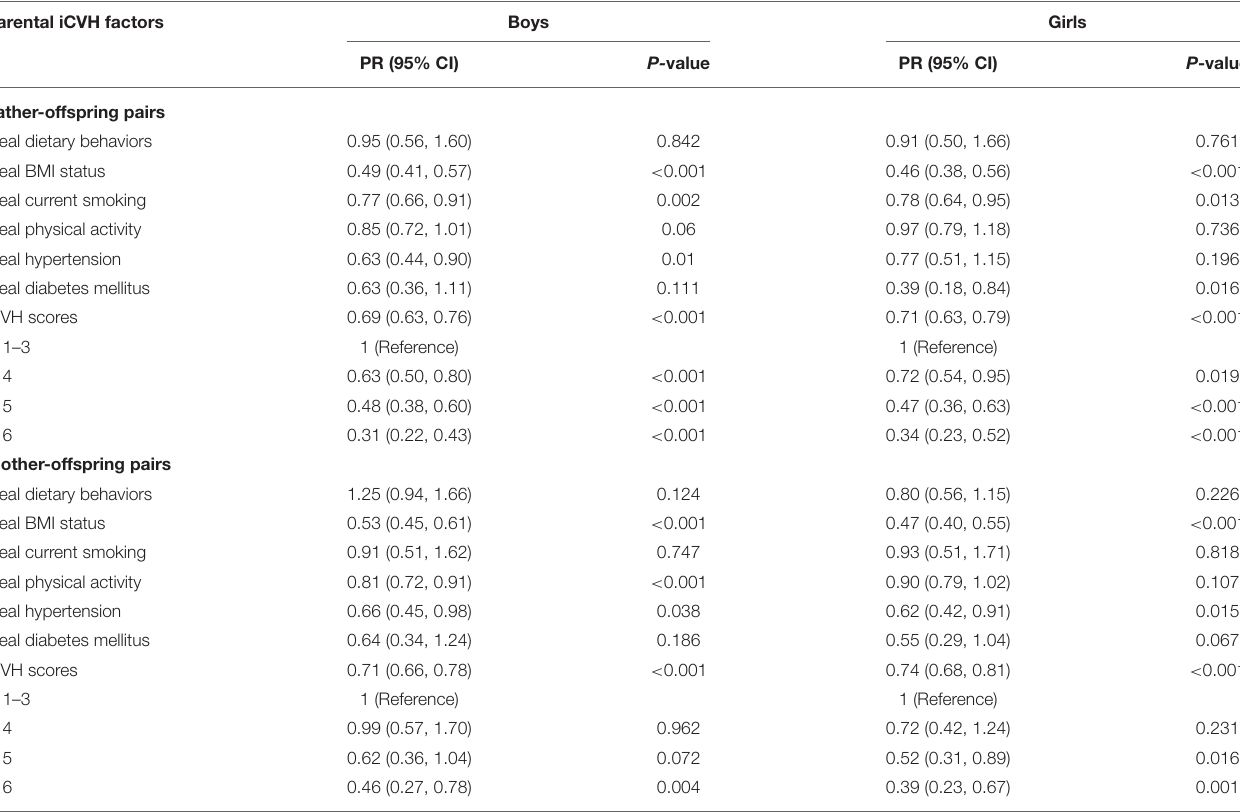
TABLE 4 | Adjusted multilevel mixed-effect models for the association between parental iCVH factors and the prevalence of offspring overweight and obesity, stratified analysis by sex. Parental iCVH